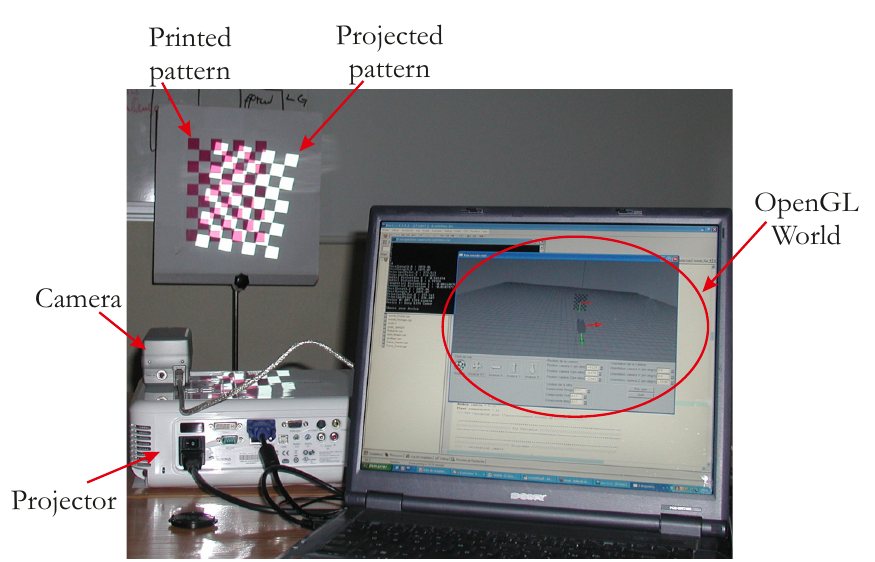
Figure 1. Setup of the system.